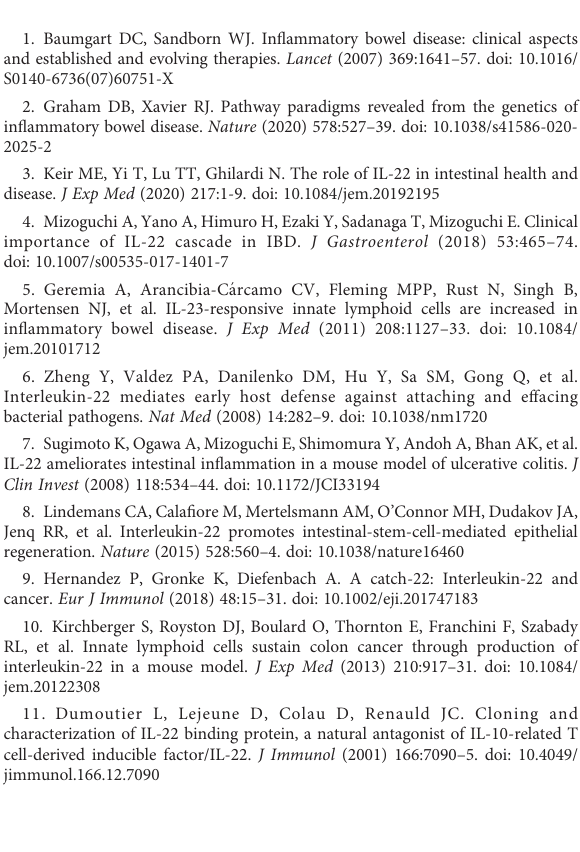
SUPPLEMENTARY TABLE 1 Clinical characteristic of controls and Crohn ’ s disease patients cohort